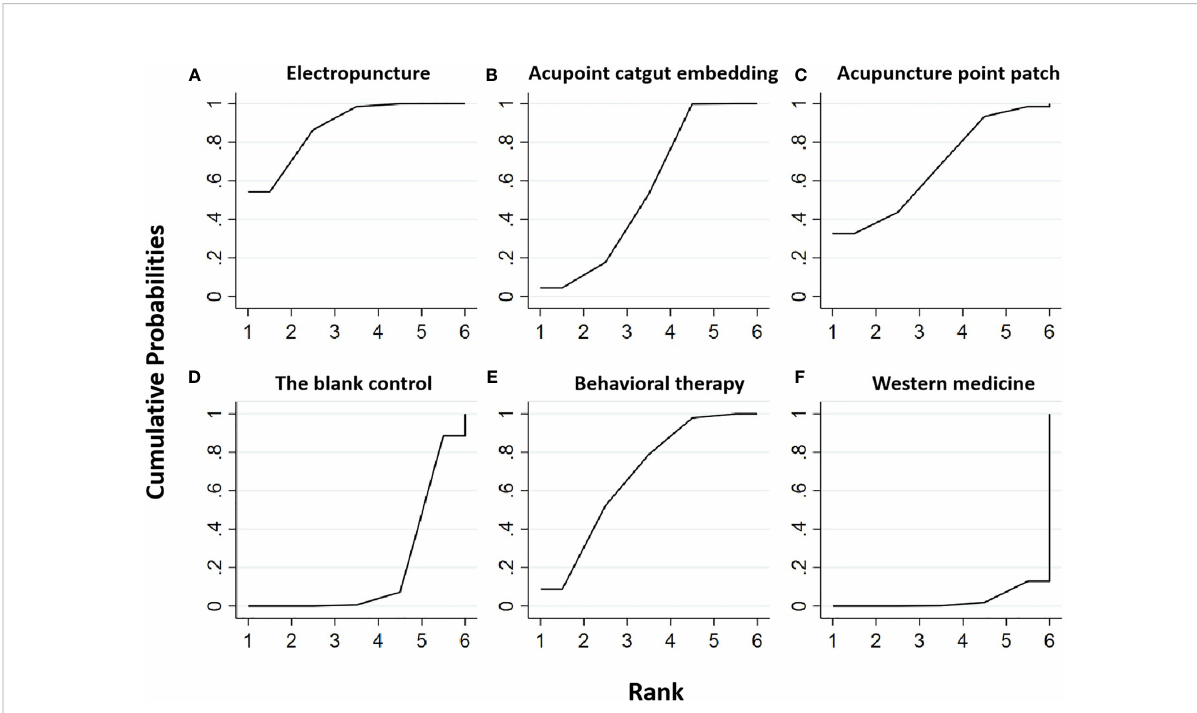
FIGURE 5 Ef fi cacy ranking and cumulative probability graph of homeostasis model assessment — insulin resistance (HOMA-IR) treated by different types of intervention. Comparison of ef fi cacy ranking and cumulative probability of HOMA-IR between each kind of intervention. (A) Electropuncture, (B) acupoint catgut embedding, (C) acupuncture point patch, (D) blank control, (E) behavioral therapy, and (F) western medicine.